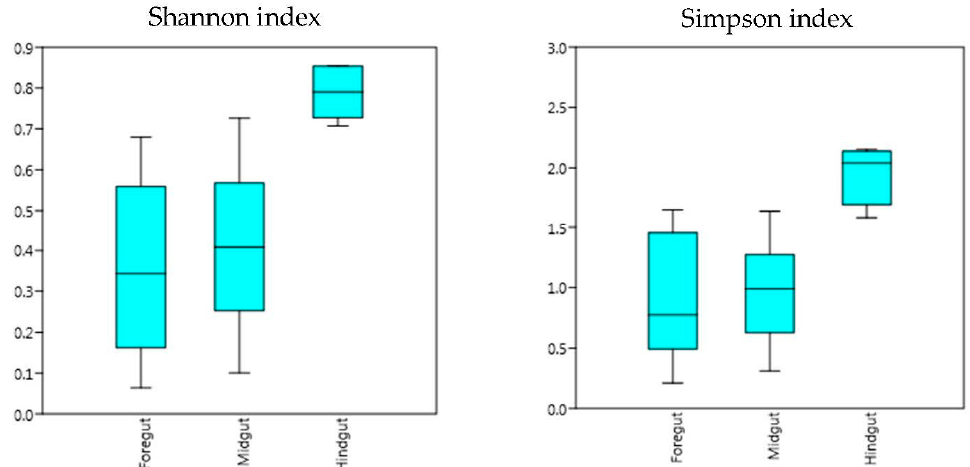
Figure 4. Shannon and Simpson diversity of microbial communities in each intestinal section (foregut, midgut, hindgut), based on plain numbers of OTUs.